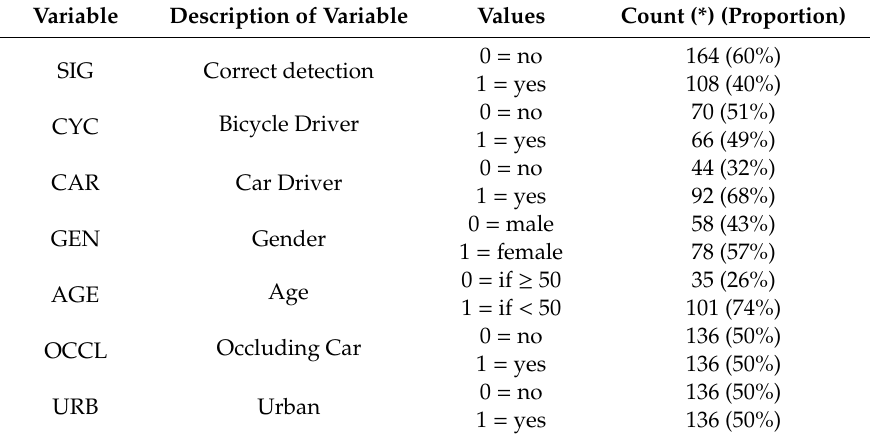
Table 1. Description of the study